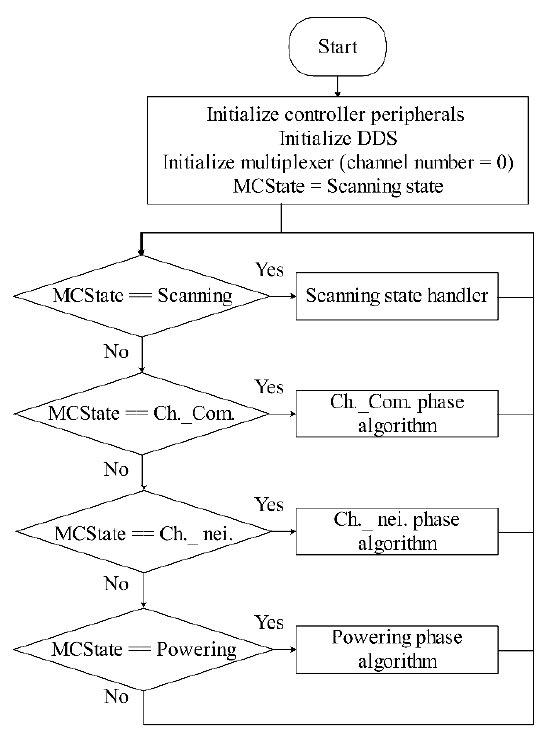
Figure 7. Main algorithm flowchart.